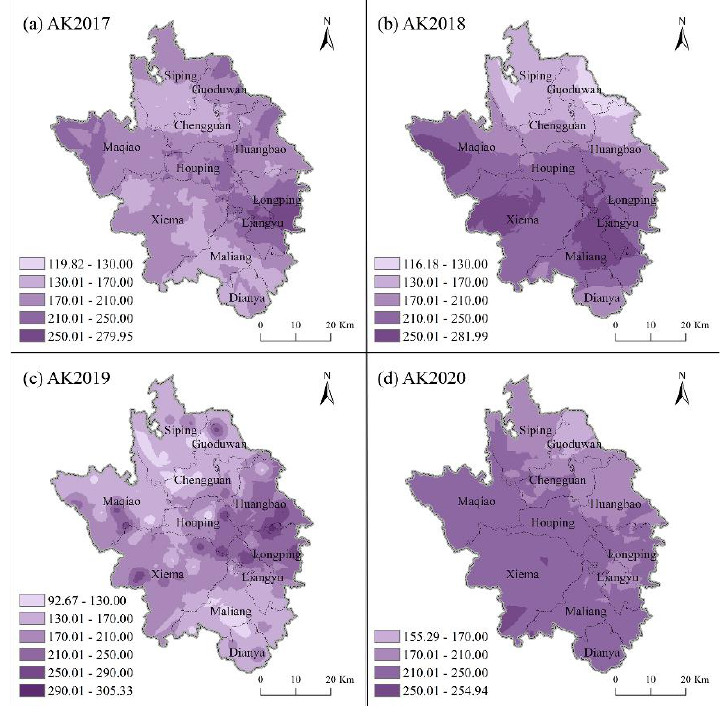
Figure 7. Ordinary kriging distribution maps for ( a ) 2017 AK, ( b ) 2018 AK, ( c ) 2019 AK and ( d ) 2020 AK.